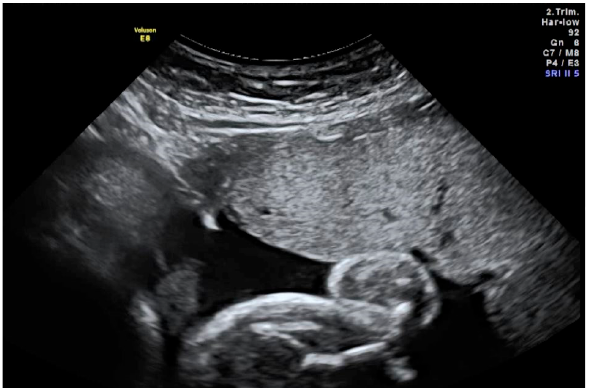
Figure 1. Ultrasound ‐ guided injection of the study drug into the amniotic cavity. Advancement of the needle must be continuously visualised. In this image, the needle tip (white) is located correctly in the amniotic fluid (black) underneath the placenta.